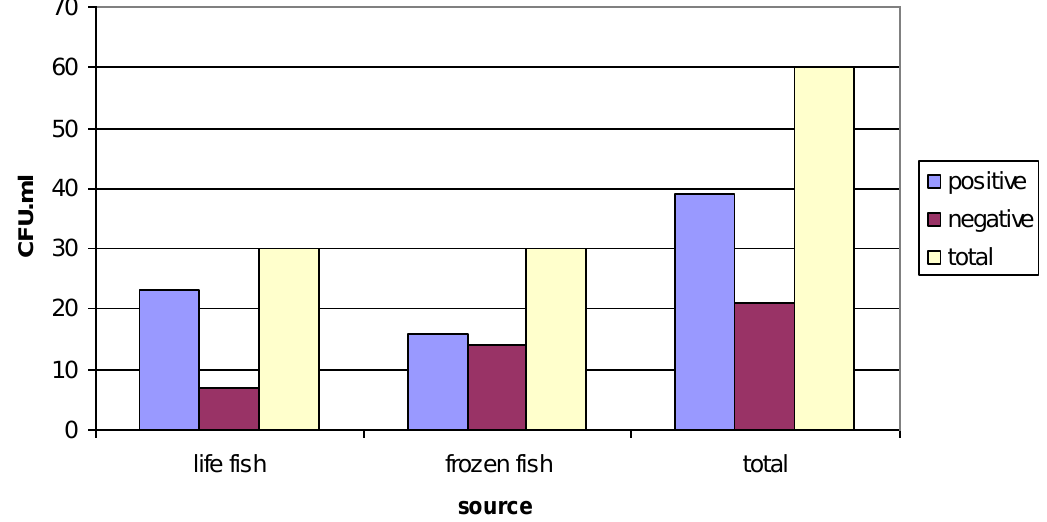
Figure – 1: The frequency percentage of Aeromonas hydrophila isolated from fish